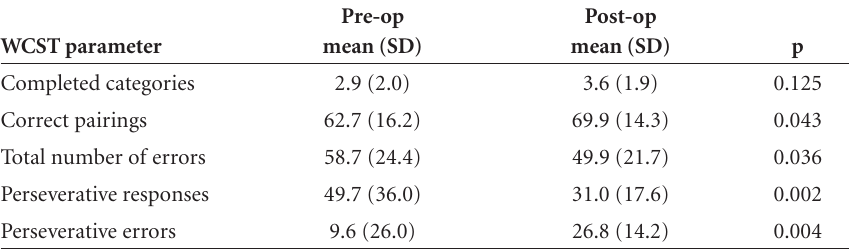
Table 3. Comparison of pre- and post- operative performance of patients with TLE/HS on the